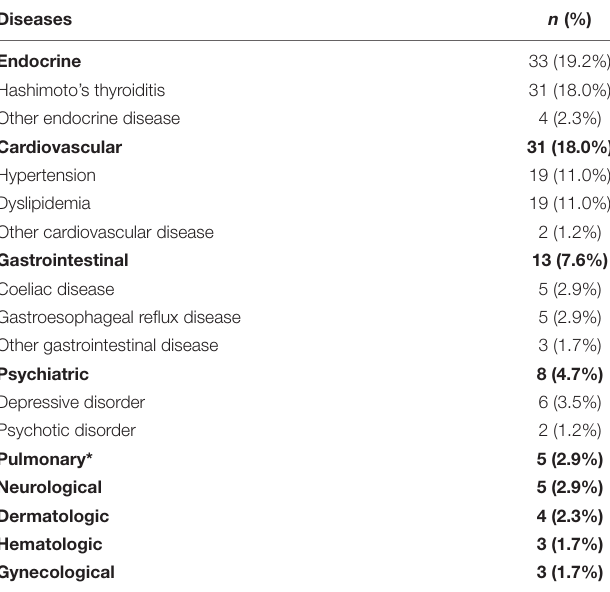
TABLE 2 | Participants with comorbid diseases (excluding diabetes-related